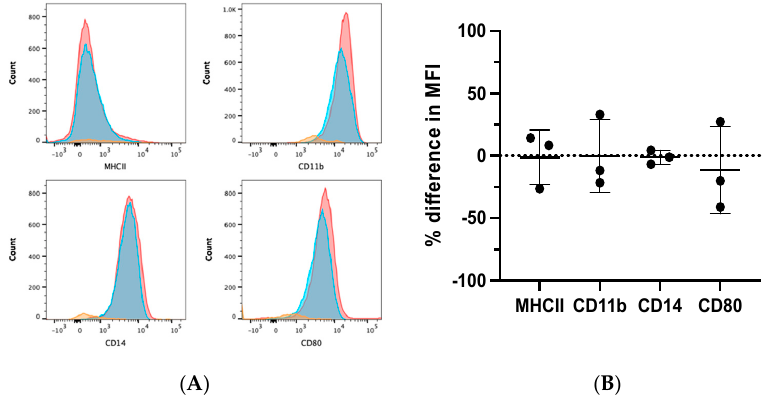
Figure 3. Phenotypic effects of ATRA on differentiating canine MDMs. Canine PBMCs were differ- entiated into MDMs in the presence of rhM-CSF (25 ng/mL), and ATRA (2 µM) or vehicle control media for 5 days. MDMs were analyzed after first gating on the myeloid cell cloud, single cells, and CD5 − cells (Supplementary Figure S1A). ( A ) Representative histograms illustrating MHCII, CD11b, CD14, and CD80 expression in control (red) and ATRA-treated (blue) MDMs. Negative expression controls (orange) consisted of FMOs for CD11b and CD80, and CD5+ INCs for MHCII and CD14. ( B ) Summary of MCHII, CD11b, CD14, and CD80 MFI in ATRA-treated MDMs, relative to control MDMs. Mean and standard deviation are shown, and individual data points are plotted. n = 3.